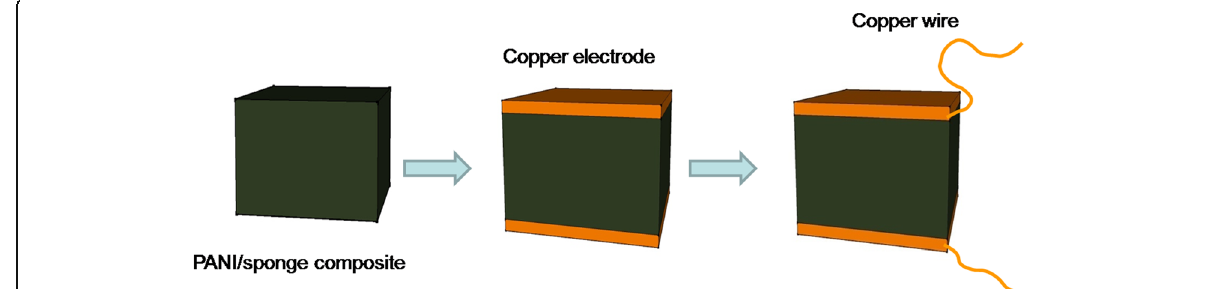
Fig. 2 Schematic of the preparation of PANI/sponge sensor